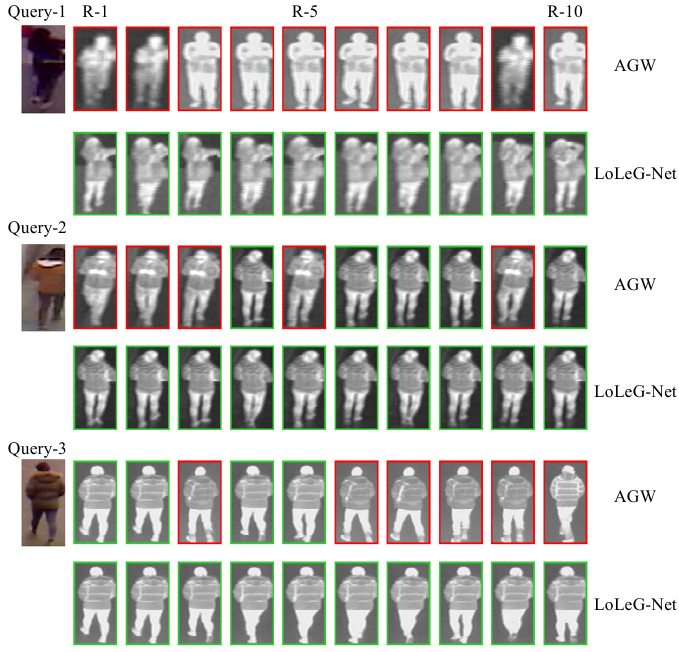
Figure 5. Visual recognition performance of AGW with LoLeG-Net for RegDB in V2I mode.